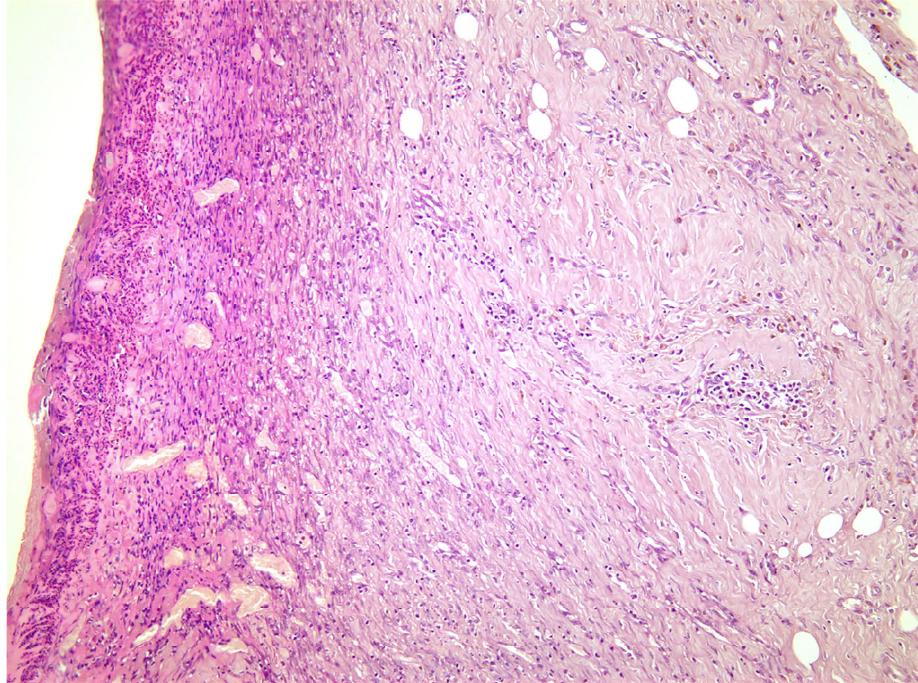
Figure A6. Histology of the wound treated with NO-CGF at post-operative day 14, hematoxylin and eosin staining, magnification—10×.